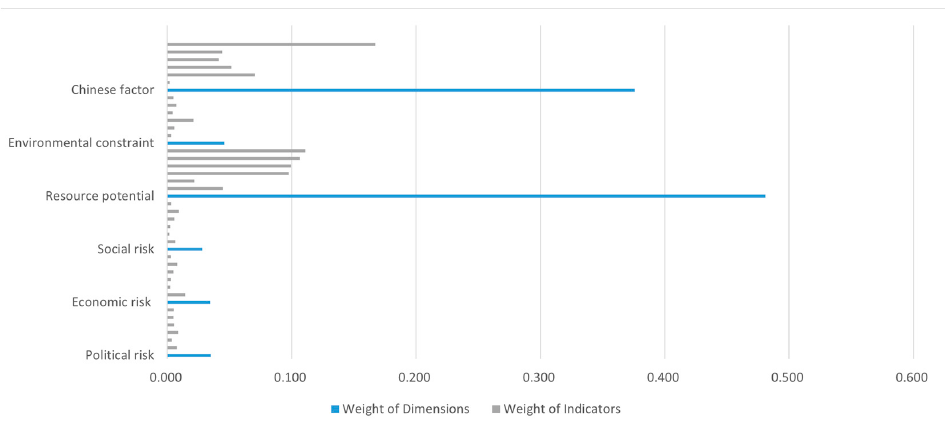
Figure 3. Determined criteria weight (6-D).